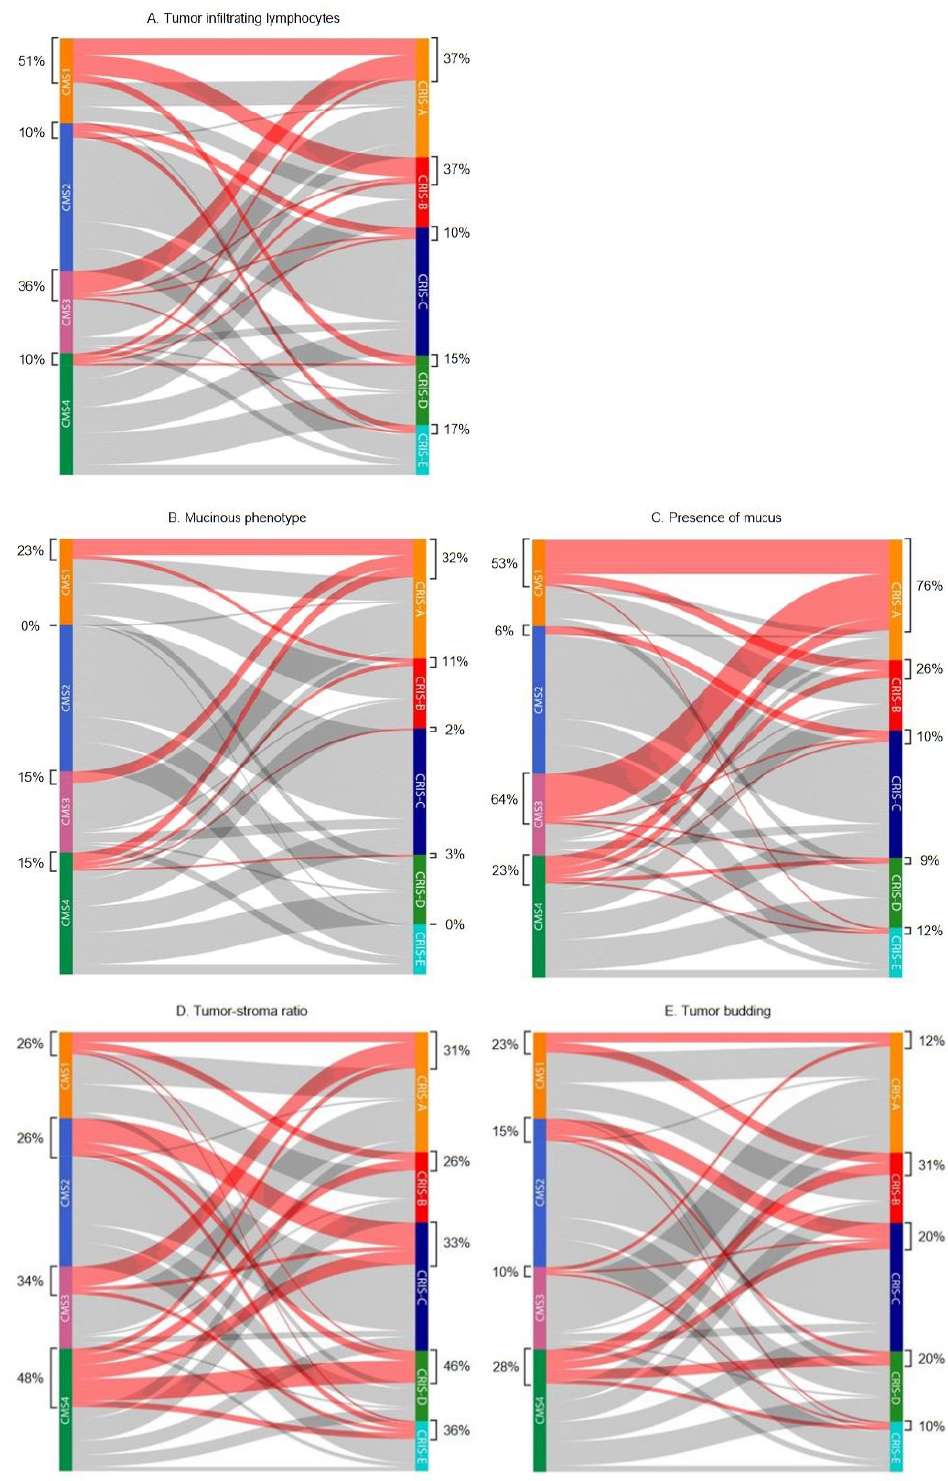
Figure 2. Sankey plots depicting the distribution of histopathological features within consensus molecular subtypes (CMS) and CRC intrinsic subtypes (CRIS). Percentages represent the number of tumors scored into a specific histopathologic category within CMS or CRIS subtypes. ( A ) Colored lines represent tumors with intermediate or high levels of tumor infiltrating lymphocytes. ( B ) Tumors with mucinous phenotype are highlighted. ( C ) Tumors containing any amount of mucus are depicted by colored lines. ( D ) Colored lines represent stroma-high tumors. ( E ) Budding-high tumors are highlighted.